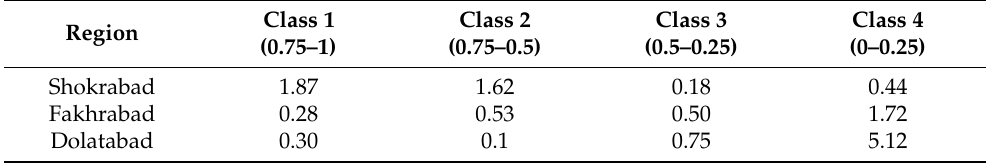
Table 7. The area (km 2 ) of different classes of recreation potential (with landscape